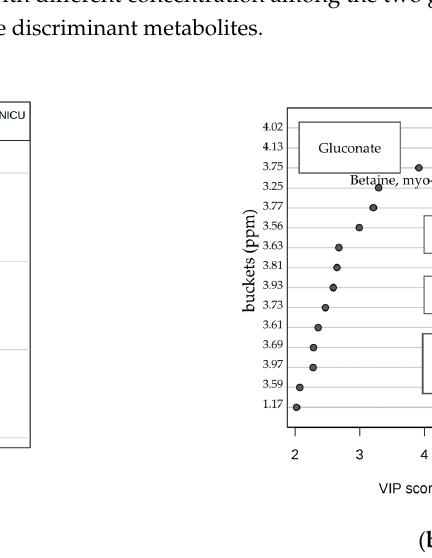
Figure 6. Multivariate analysis of NMR data belonging to neonates diagnosed with LOS (orange circles) and control neonates of NICU (blue circles). ( a ) PLS-DA scores plot of the LOS and control. ( b ) VIP scores and metabolites related to buckets with different concentration among the two groups.